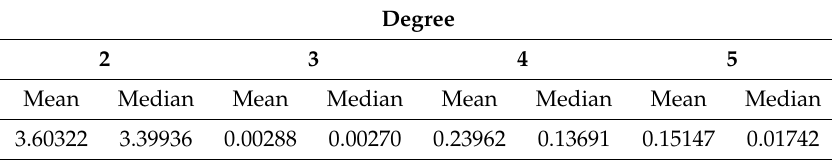
Figure 8. Example 2. Resistor-average distances between the sample and estimated models. The figure on the right enlarges the previous one for a better view. Table 6. Example 2. Means and medians of the resistor-average distances between estimated and sample unidimensional distributions.